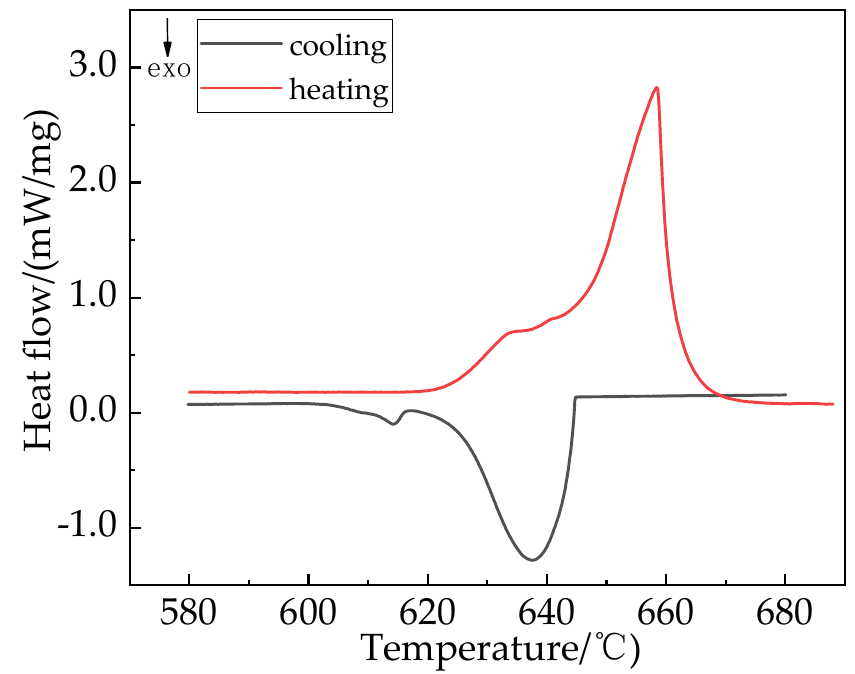
Figure 5. DSC curve of the as-cast Al-Zn-In-Er alloy. According to the Al-Er binary phase diagram [3], the peak at 614.3 ◦ C of the cool- ing DSC curve possibly corresponds to the melting point of the quasi-eutectic structure ( α (Al) + Al 3 Er) [34], which is similar to general Al-Cu alloy, where the DSC endothermic peak at 532 ◦ C is largely caused by the melting of the Al 2 Cu phase [35–37] and the onset at 627.7 ◦ C is related to the initial melting point of the α (Al) matrix [38]. Natively, the UHTT temperature should not exceed 627.7 ◦ C, since the solid solubility of Er in Al is small [14], only approximately 0.6 wt.%, and the diffusion of Er in Al is low [18]. To explore the evolution of the microstructure, the UHTT experiments were carried out at 585 ◦ C, 595 ◦ C, 605 ◦ C, 615 ◦ C and 625 ◦ C for 24 h [4,5,20], followed by annealing. At the UHTT selected temperature, UHTT was performed at 16 h, 24 h, 32 h and 40 h to explore the impact of time on the evolution of the microstructure.